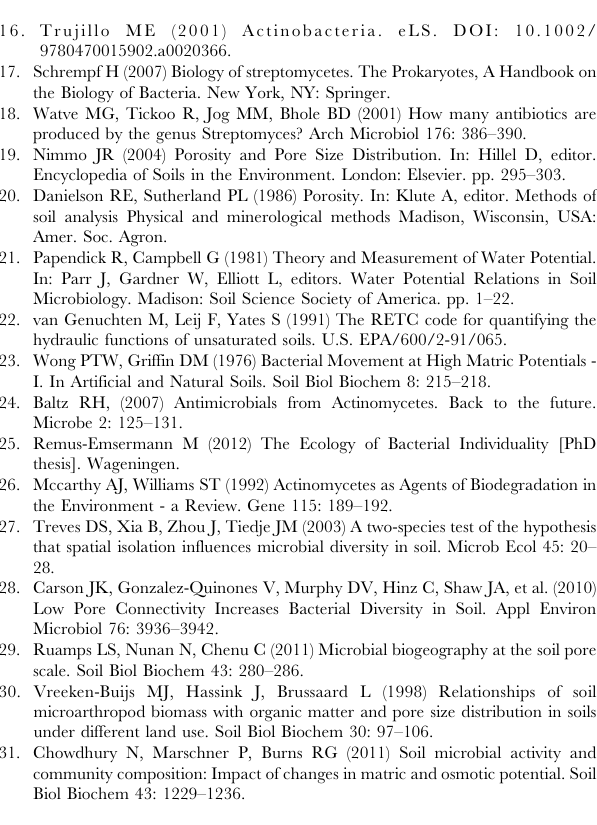
Figure S1 Schematic design for measurements of bacterial motility. Microcosms containing sand with different pore size distributions and matric potentials were established in glass petri dishes. The microcosms were inoculated in the middle with an overnight culture of either Streptomyces or Bacillus ( =inoculation point). A multi-pronged sampling device was used at 24 and 48 h to measure the bacterial expansion in four directions by transferring bacterial cells with the prongs from defined distances ( =sampling points) onto agar plates where colony formation was observed. Figure S2 Water retention curves of the 3 sand fractions used in the experiments, showing the water-filled pore space at each matric potential. Figure S3 Growth curves of Bacillus weihenstephanen- sis and Streptomyces atratus in 10% tryptic soy broth (n =6). Error bars represent the standard error of the mean.